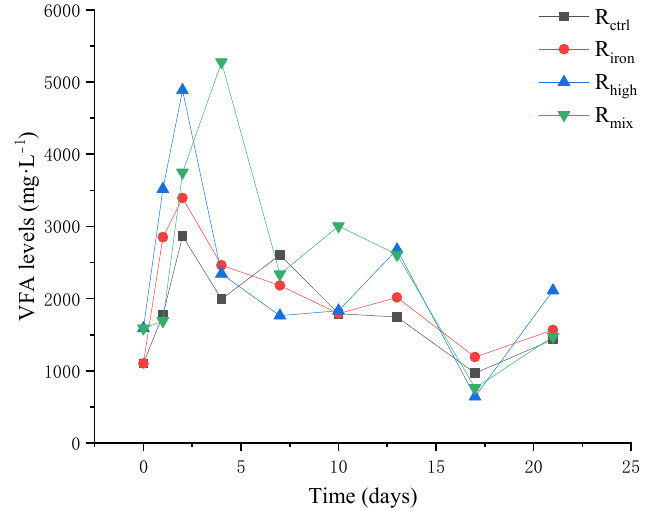
Figure 2. VFA levels of the four reactors.